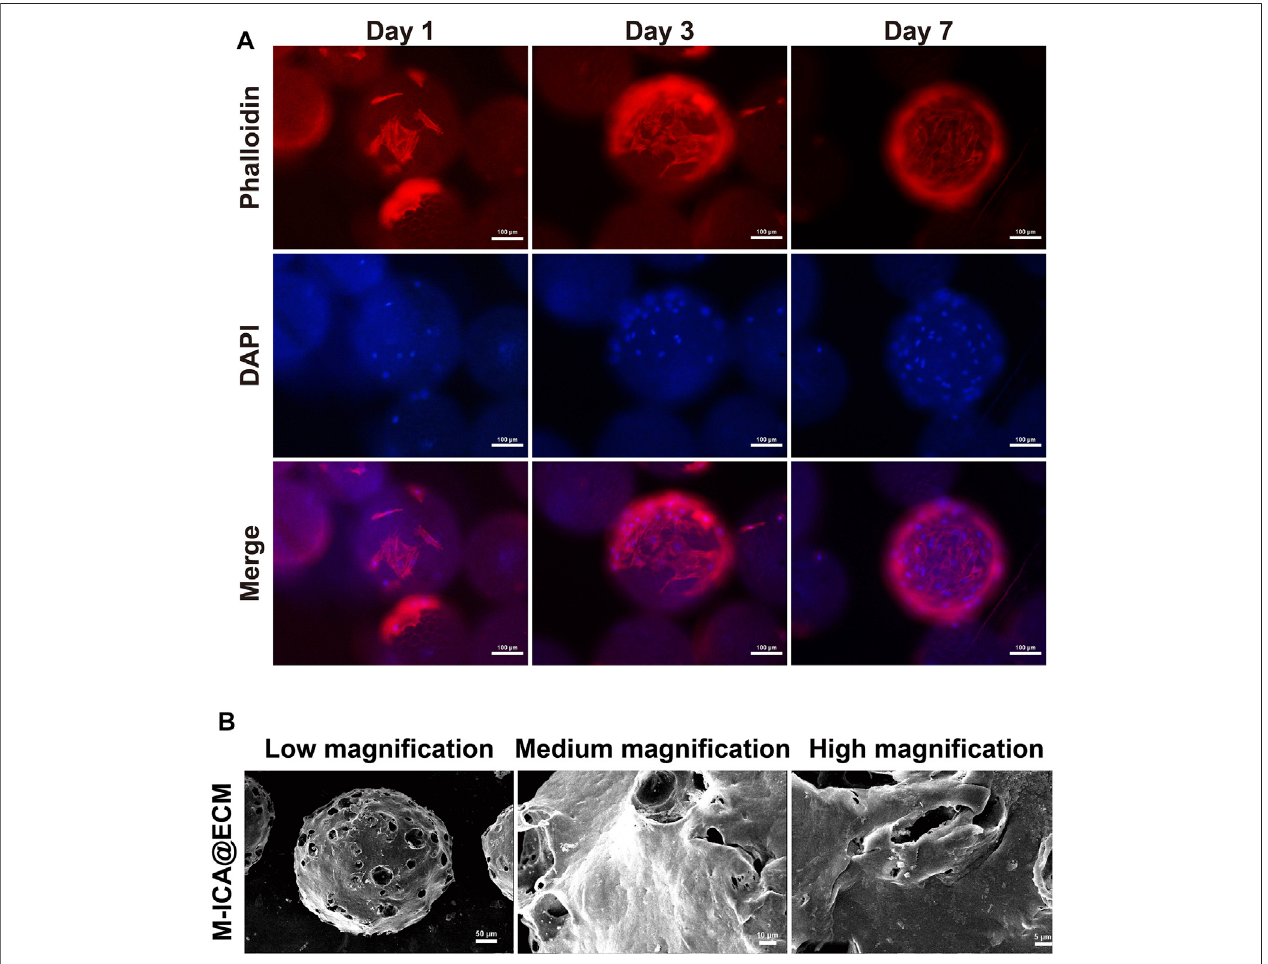
FIGURE 4 | (A) Morphology of adhered BMSCs on M-ICA for 1, 3, and 7 days observed via rhodamine — phalloidin (actin micro fi laments, red)/DAPI (nuclei, blue) staining (scale bar = 100 μ m). (B) The morphology of M-ICA@ECM microcarrier observed under SEM (scale bar = 50 μ m for low, 10 μ m for medium, 5 μ m for high magni fi